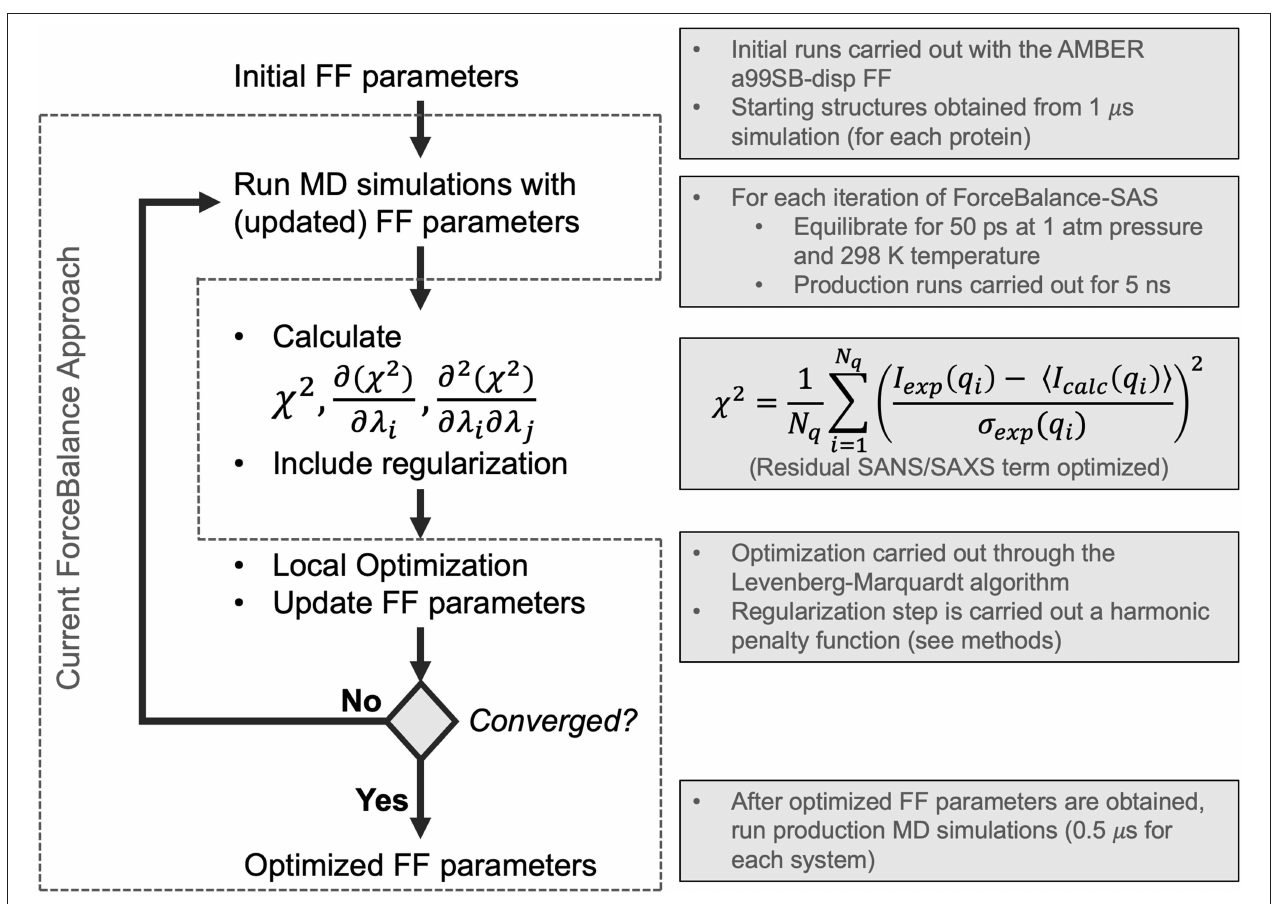
FIGURE 1 | Flowchart depicting the ForceBalance-SAS algorithm. An initial set of parameters is input, followed by MD simulation and calculation of ensemble-averaged small-angle scattering intensities. After the simulation stops, the residual between the simulated and experimental scattering intensities is calculated, along with the gradients and Hessians of the residual. If the desired convergence criteria are met, the algorithm stops, and the new force field parameters are output; if not, optimization is performed, a new set of parameters are obtained, and a simulation with the updated parameters are performed, completing the cycle. The current implementation of the ForceBalance ( Wang et al., 2014) approach is demarcated from our approach using dotted